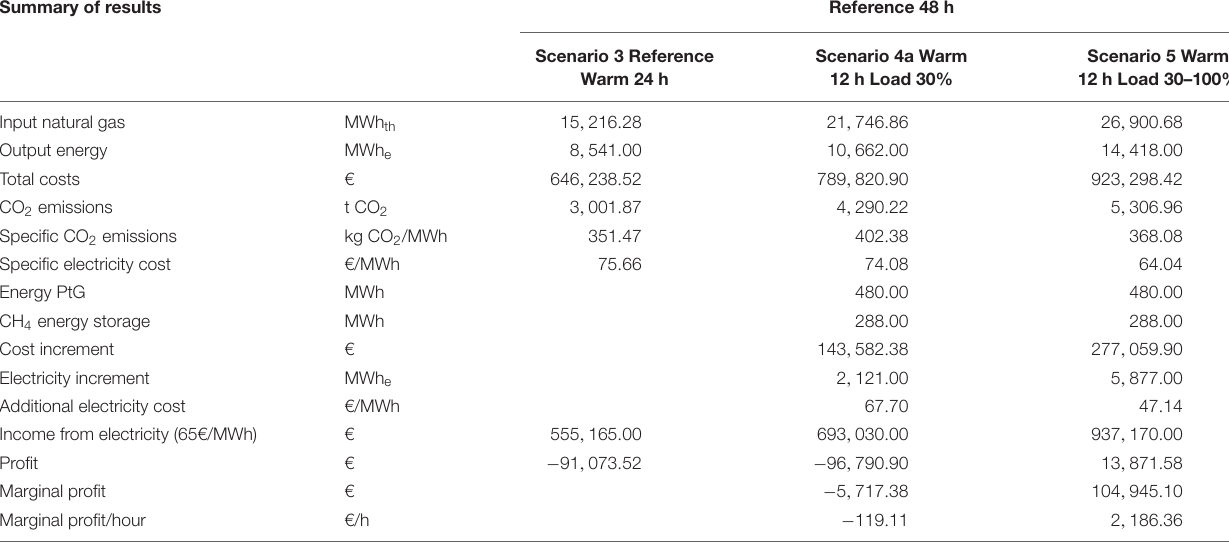
TABLE 7 | Comparison of different operation modes during the period of warm start-up. Summary of